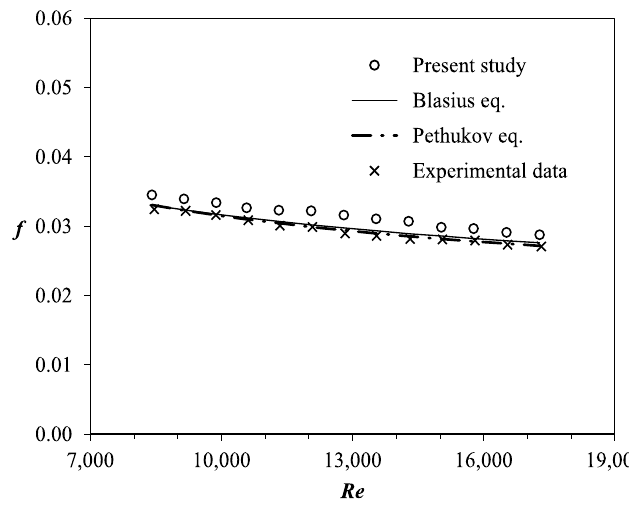
Figure 3. Validation of f for plain tube.